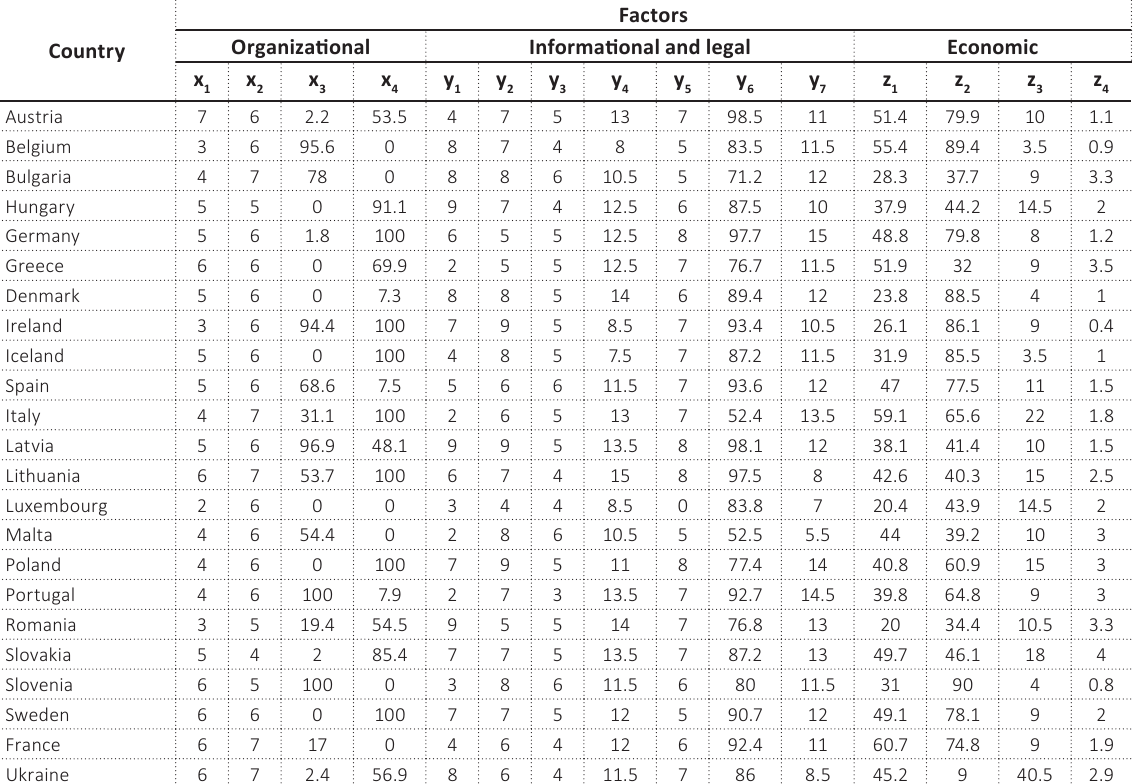
Source: The World Bank